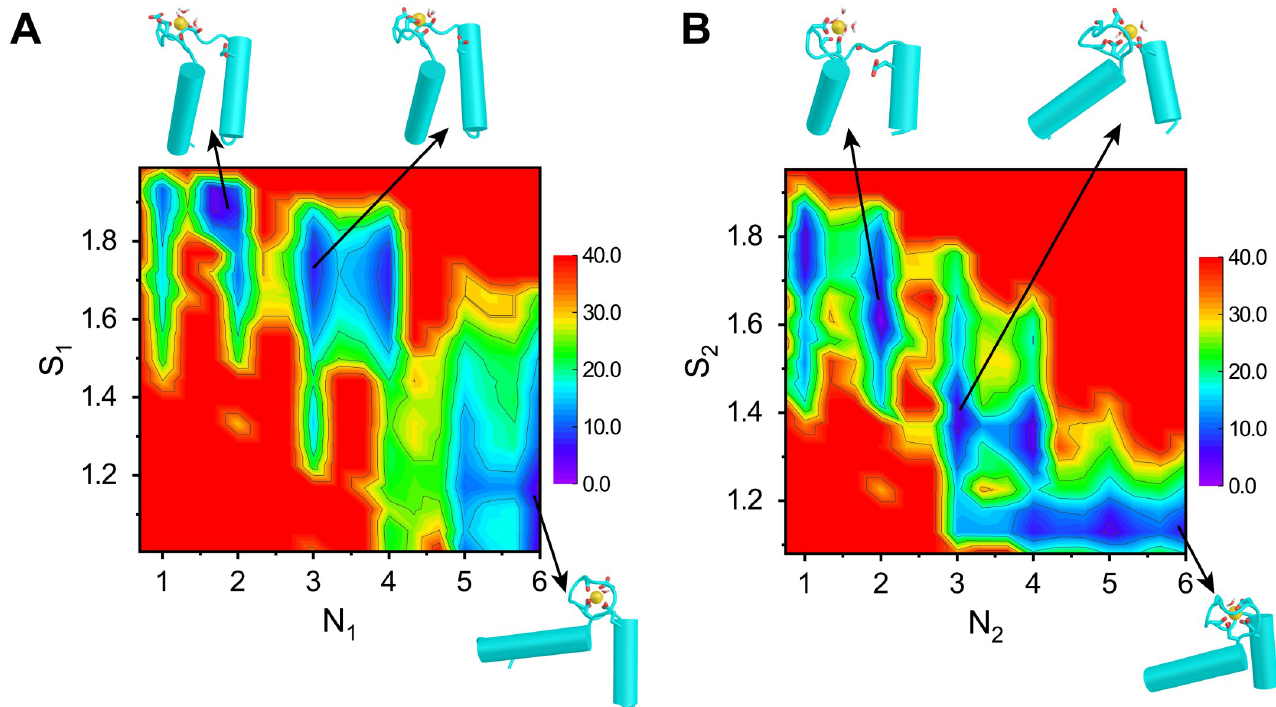
Fig 2. Free energy profiles of the Ca 2+ coupled conformational transitions of EF 1 (A) and EF 2 (B) projected onto the collective variables ( N 1 , S 1 ) and ( N 2 , S 2 ), respectively. Representative conformations of the major basins in the landscape are also shown. The unit of the free energy is kJ/mol.